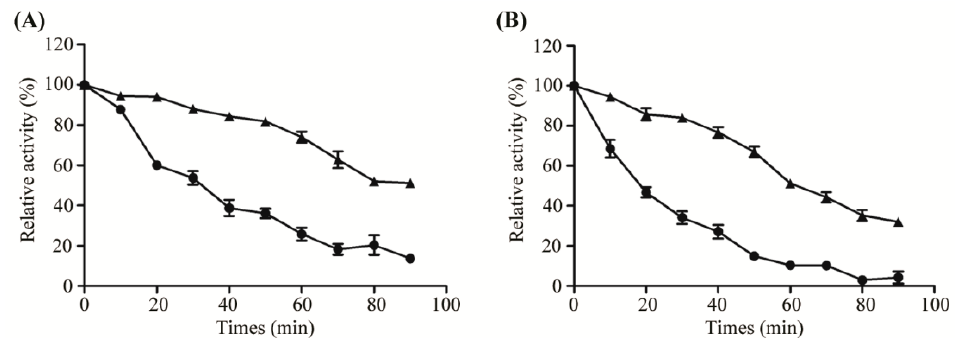
Figure 4. Thermo-stability of free (circles) and immobilized (triangles) Aly08 at 37 ◦ C ( A ) and 45 ◦ C ( B ). Residual activities were measured at 45 ◦ C and pH 8.0. The activity of enzyme without incubation was defined as 100%.